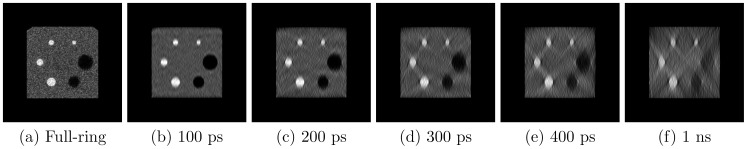
Reconstructed images of NEMA-IQ phantom obtained from TOF-PET data with different timing resolutions.Note that only the structures inside the ROI are displayed.